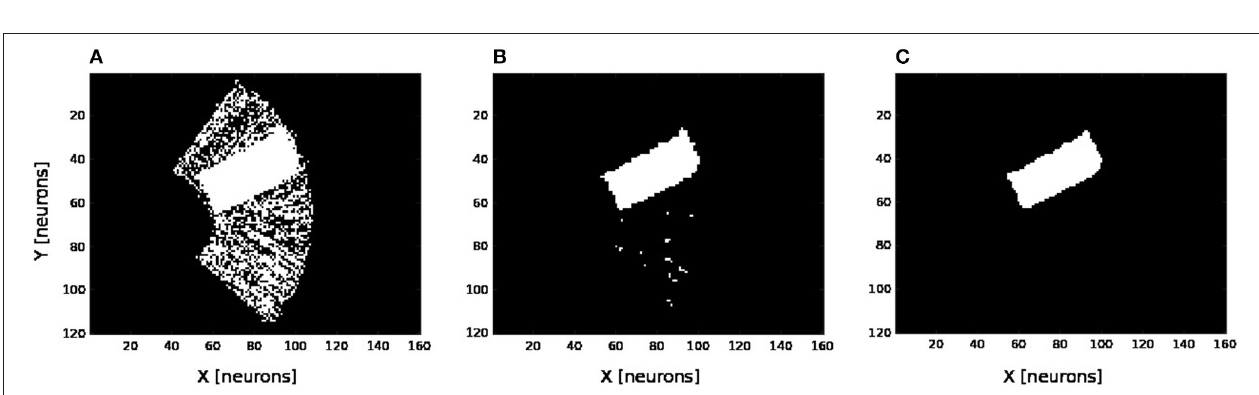
FIGURE 7 | Noise filtering operation. After the visual prediction of the whole arm location as showed in Figure 6 , we add a filtering operation to denoise the erronous and isolated units till having a uniform density distribution; for the motor angle 30 ◦ . (A) Before denoising. (B,C) After denoising in two